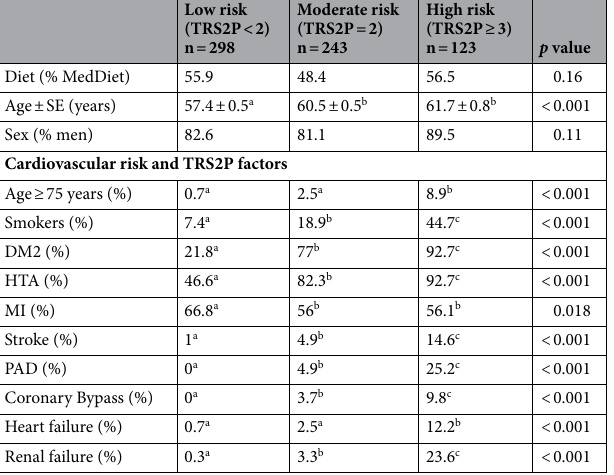
Table 1. Baseline characteristics of the patients, according to TRS2P risk group. TRS2P, Thrombolysis in Myocardial Infarction Risk (TIMI) Score for Secondary Prevention; MedDiet, mediterranean diet; DM2, diabetes mellitus type 2; HTA, hypertension; MI, myocardial infarction; PAD, peripheral artery disease; SE, standard error. Values in the same row with different letters are significantly